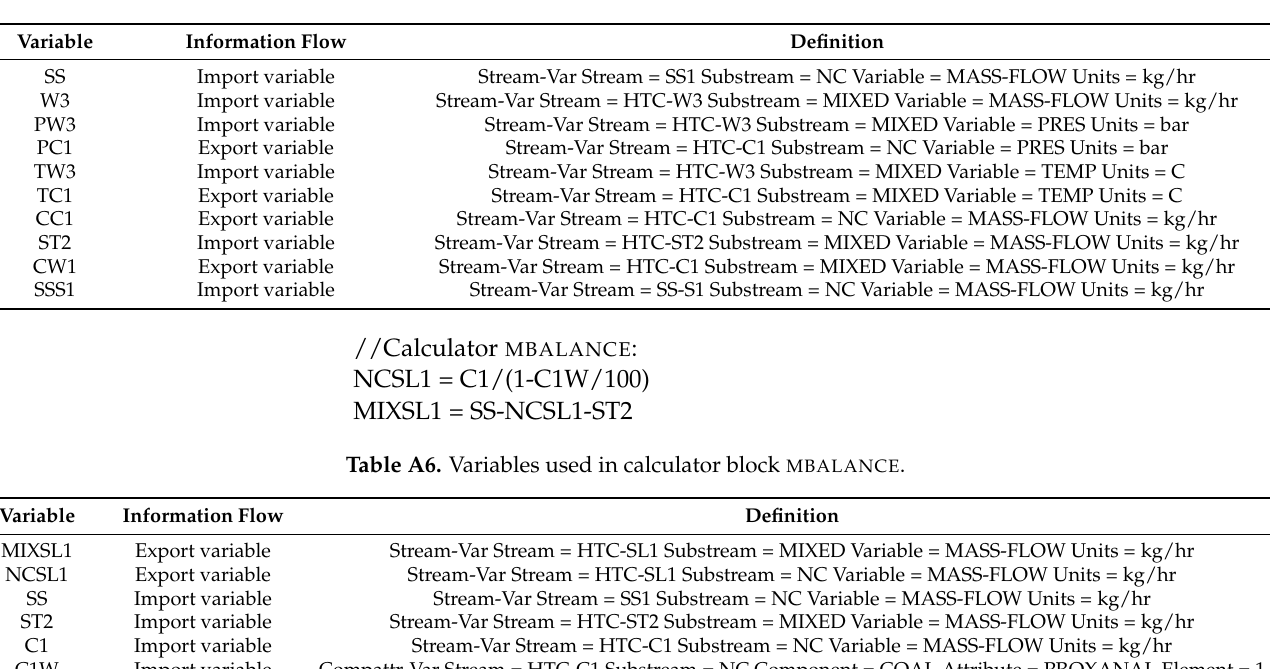
Table A5. Variables used in calculator block ADDHTC - C .